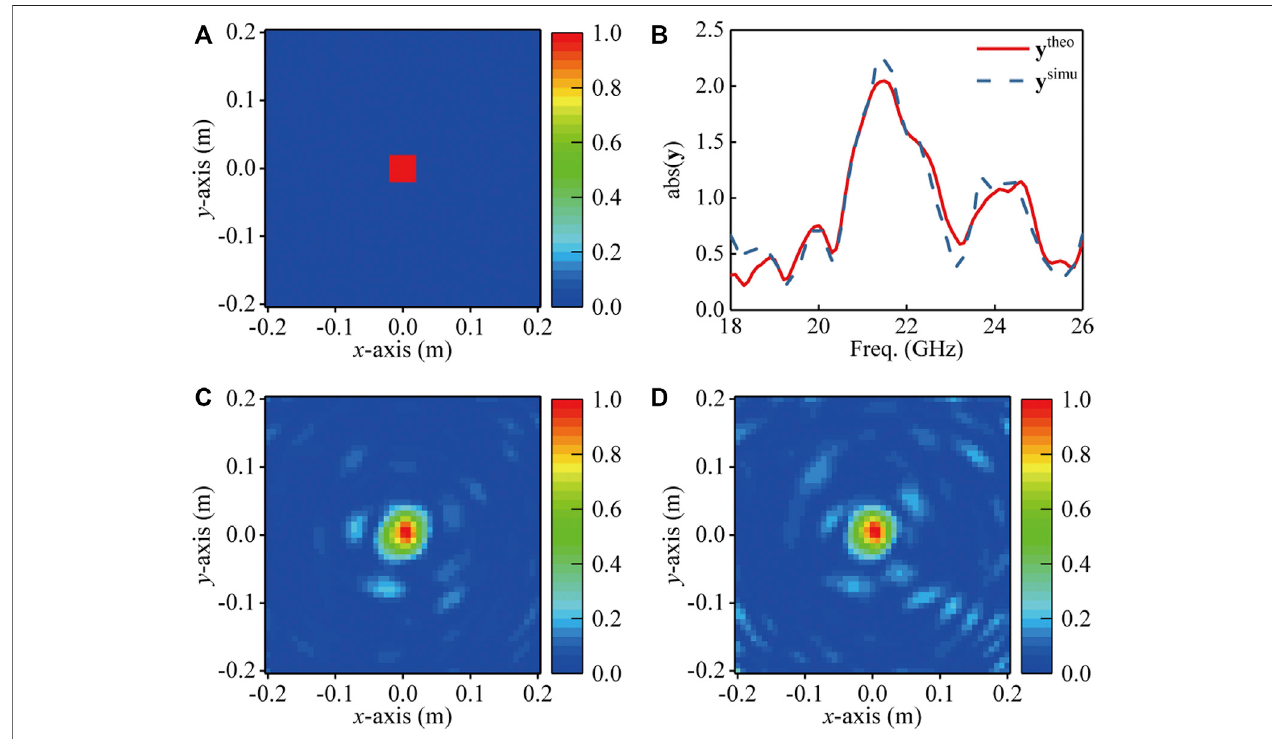
FIGURE 4 | (A) Square PEC object. (B) Comparison of the calculated y theo and simulated y simu . (C) The reconstructed imaging x theo using y theo . (D) The reconstructed imaging x simu using y simu